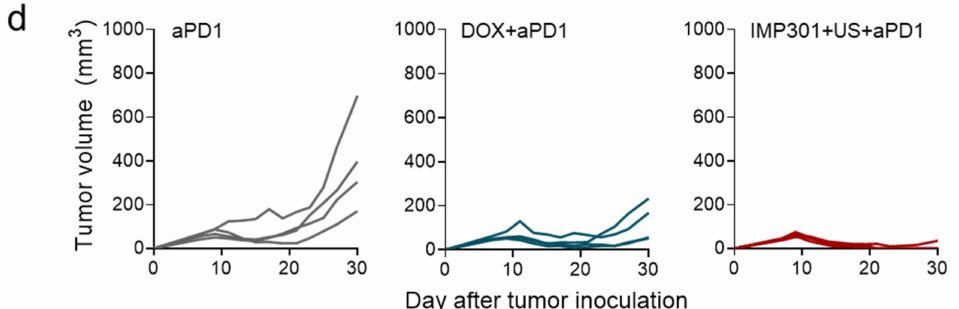
Figure 5. In vivo therapeutic efficacy of the combination of aPD1, IMP301, and US treatment in 4T1 tumor-bearing mice. ( a ) Schematic illustration of the treatment protocol; ( b , c ) changes in tumor size as a function of time. ( d ) Individual tumor growth in volume ( n = 4).